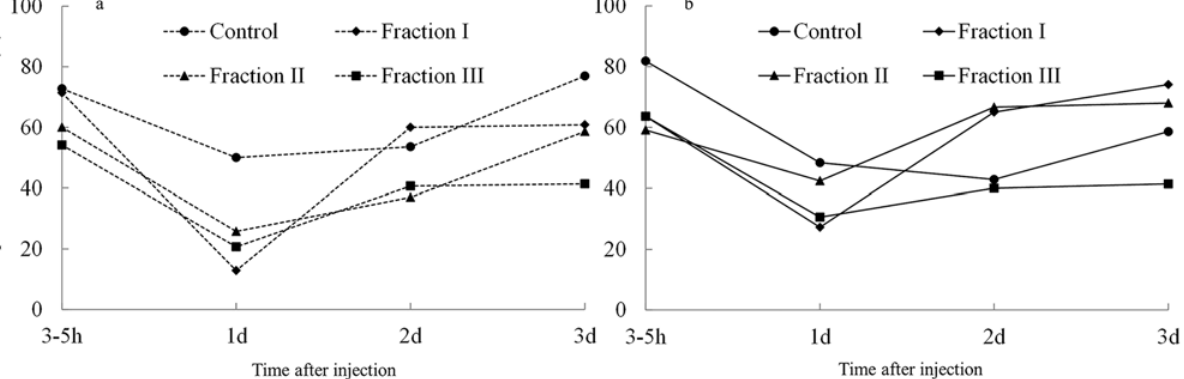
Fig 3. Receptivity to mating in virgin females (N = 20 – 36 per block and treatment group) injected with a fraction of male accessory gland extract (Fraction I [molecular weight < 25 kDa], Fraction II [MW, 25 – 50 kDa], or Fraction III [MW > 50 kDa]) or with Milli-Q water only (control), at 3 – 5 h, 1, 2, and 3 d after injection. The two panels and represent the two experimental blocks.